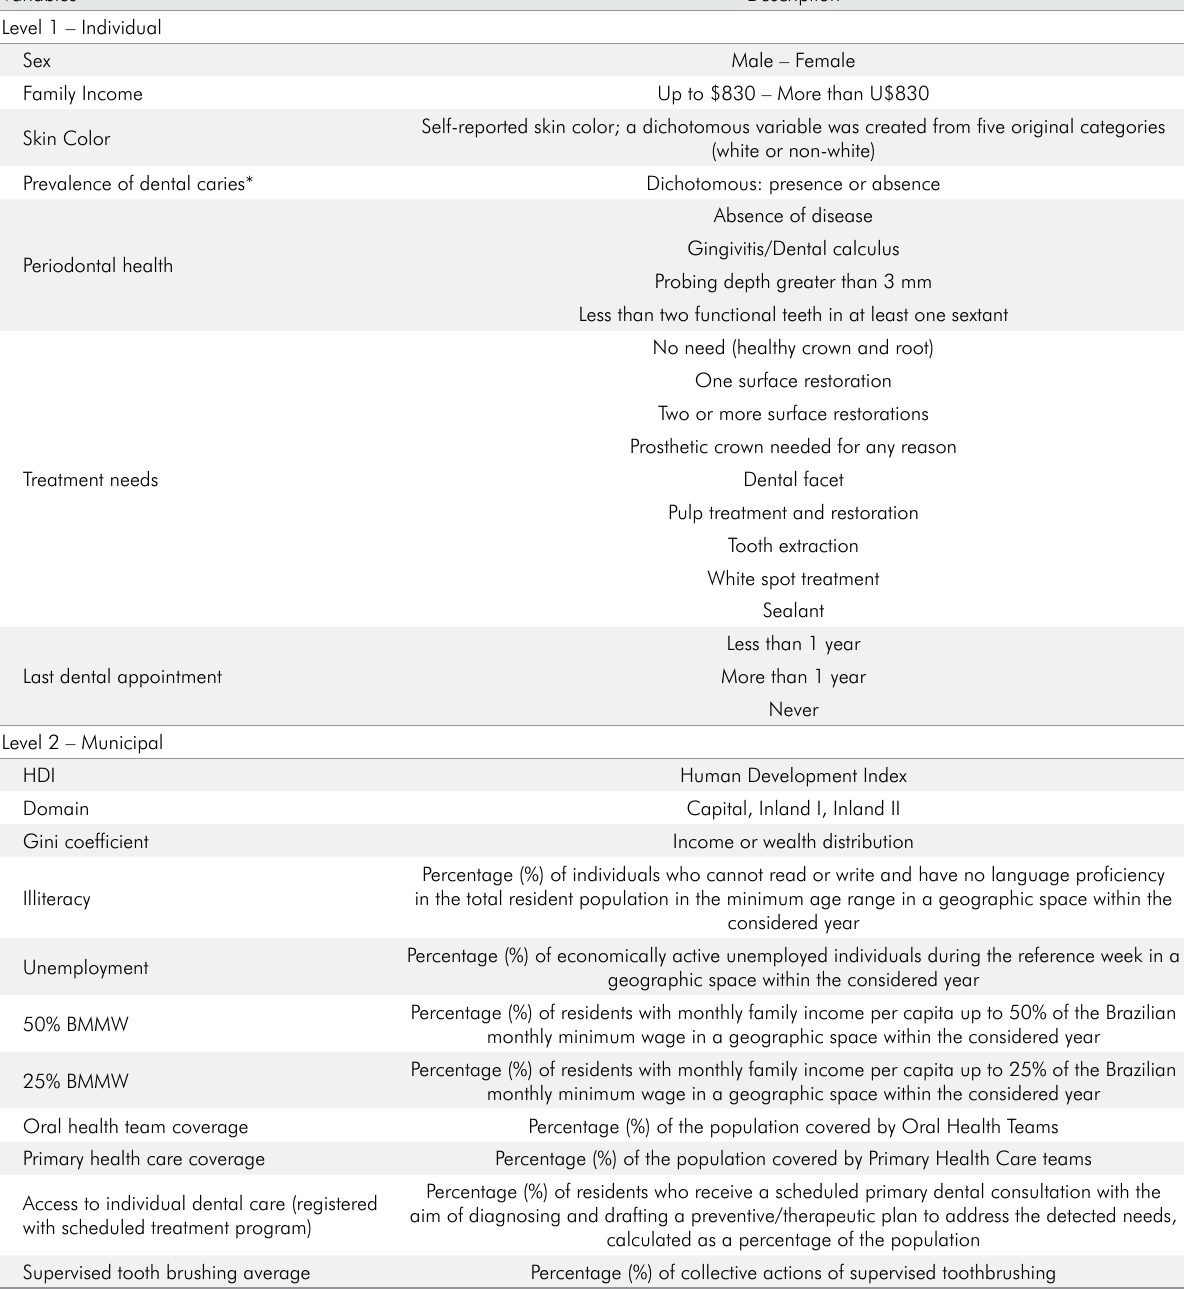
Table 1. Description of independent variables according to the level of analysis involving adolescents, SB Minas Gerais, Brazil, 2012.